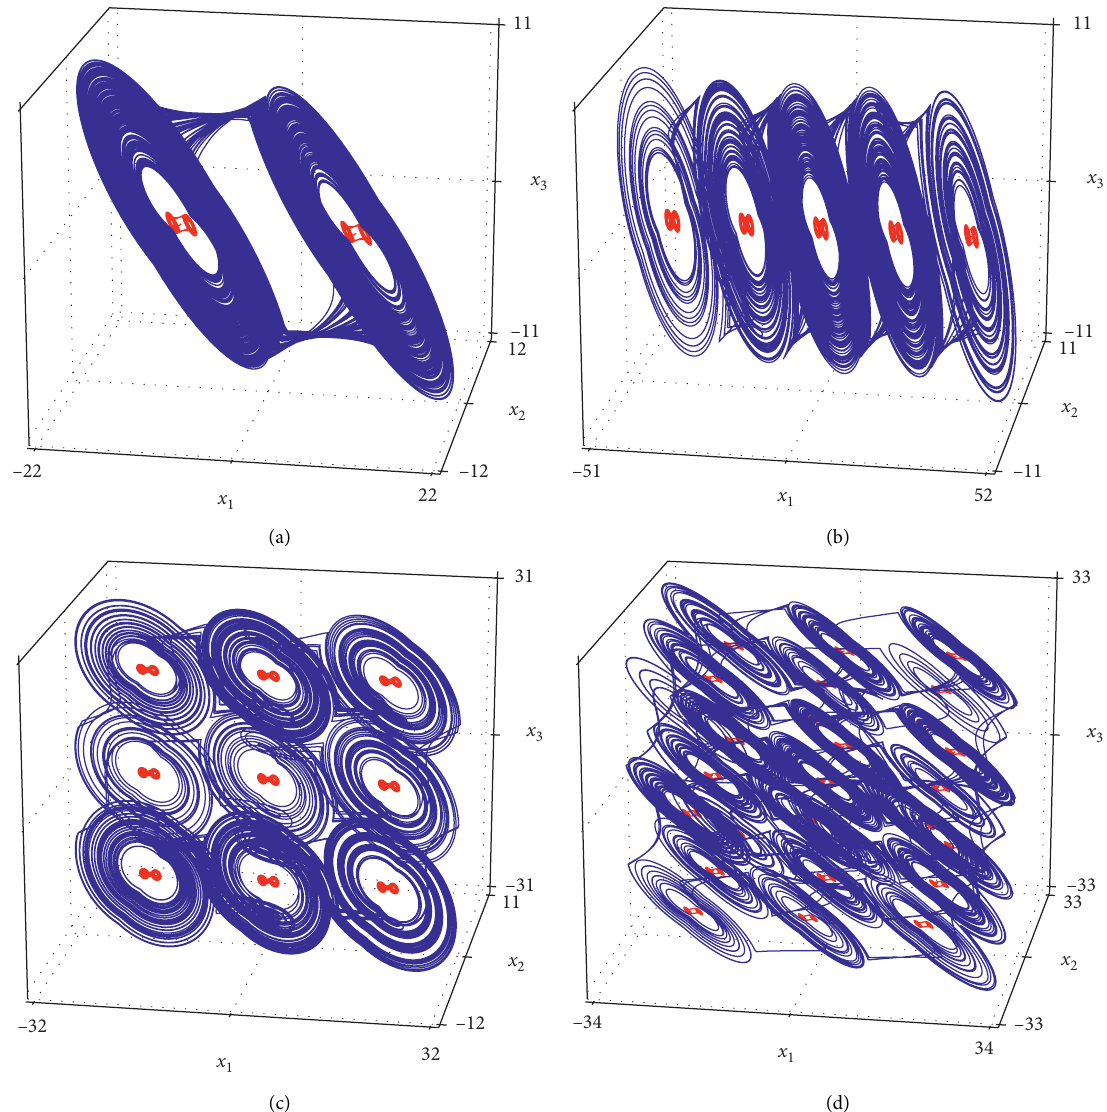
Figure 4: Simulation of the hidden attractor (in blue) and the self-excited attractors (in red) exhibited by system (43) with parameters a � 0 . 2, b � 5, and c � − 7. In (a) and (b) B ( x ) is given by (44) with N E � 0 , E � 1 ,N � 2, and N � 2. In (d) B ( x ) is given by (48) with E x 1 x 3 2 3